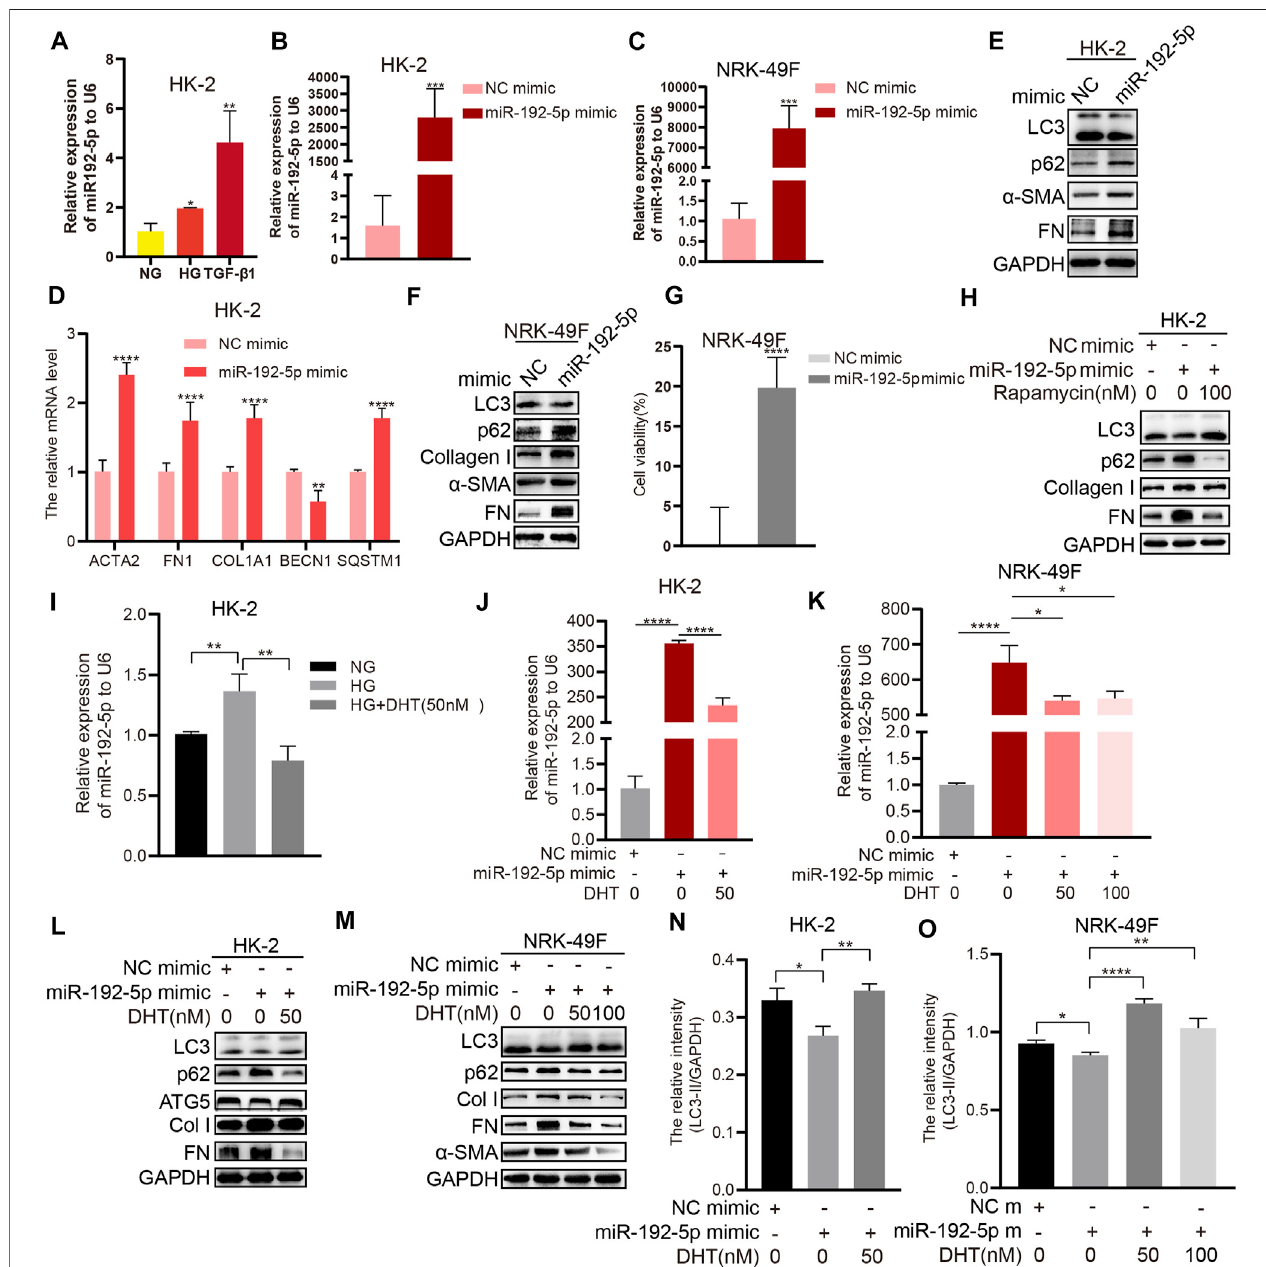
FIGURE 5 | DHT induces autophagy and reduces fi brosis by down-regulating miR-192-5p expression (A) Real-time PCR detection of miR-192-5p after HK-2 cells stimulated with HG and TGF- β 1. n (cid:1) 3; * p < 0.05, ** p < 0.01 (B – C) Relative expression of miR-192-5p in HK-2 and NRK-49F cells transfected with miR-192-5p mimic. *** p < 0.001 (D) Relative mRNA levels of BECN1 , SQSTM1 , COL1A1 , ACTA2 , and FN1 in HK-2 cells transfected with miR-192-5p mimic. ** p < 0.01, **** p < 0.0001 (E – F) The expression of LC3, p62, α -SMA, Col I, and FN in HK-2 and NRK-49F cells transfected with miR-192-5p mimic (G) The cell viability in NRK-49F cells transfected with miR-192-5p mimic. **** p < 0.0001 (H) HK-2 cells were transfected with miR-192-5p mimic and treated with rapamycin, the expression ofLC3,p62,Col I,and FN was detected (I) Relative expression ofmiR-192-5p in HK-2cells treated with HGand DHT. ** p < 0.01 (J – K) Relative expressionofmiR-192-5pinHK-2andNRK-49FcellstransfectedwithmiR-192-5pmimicandtreatedwithDHT.* p < 0.05,**** p < 0.0001 (L – O) TheexpressionofLC3,p62, ATG5, α -SMA,ColI,andFNinHK-2andNRK-49FcellstransfectedwithmiR-192-5pmimicandtreatedwithDHTwasdeterminedbyWesternblotandtherelativeintensity of LC3-II was analyzed by the ChemiScope analysis software (* p < 0.05, ** p < 0.01, **** p < 0.0001).